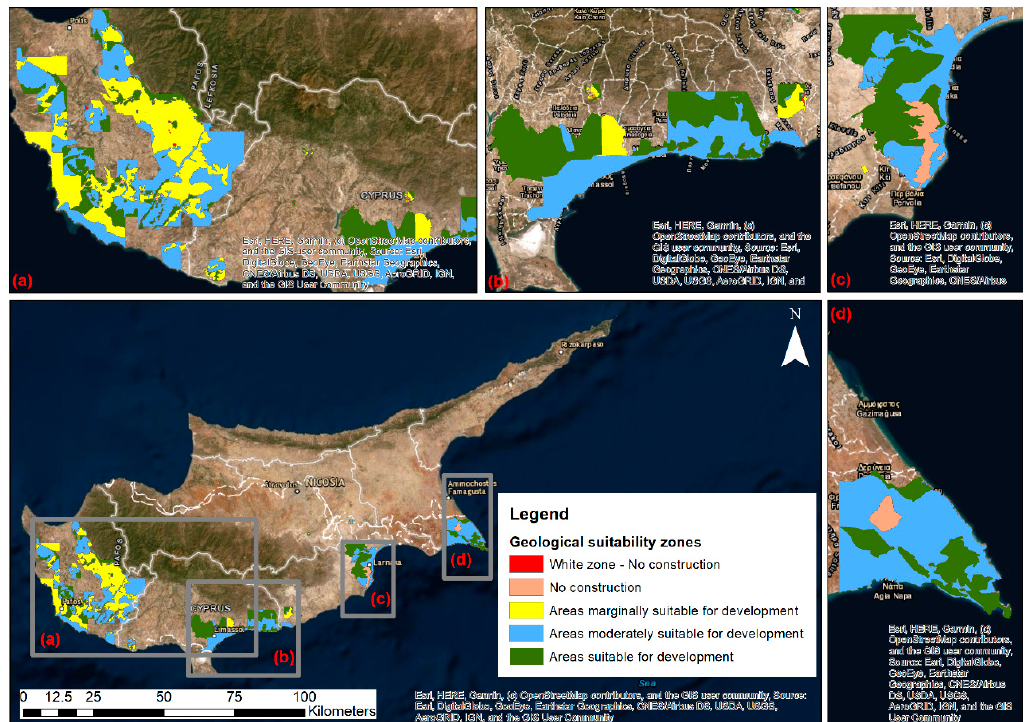
Figure 3. Geological suitability zone map of Cyprus. It covers ( a ) the mountainous and semi- mountainous Paphos District, and small parts of ( b ) Limassol, ( c ) Larnaca, and ( d ) Famagusta. Digitized map based on data provided by the Cyprus Geological Survey Department.